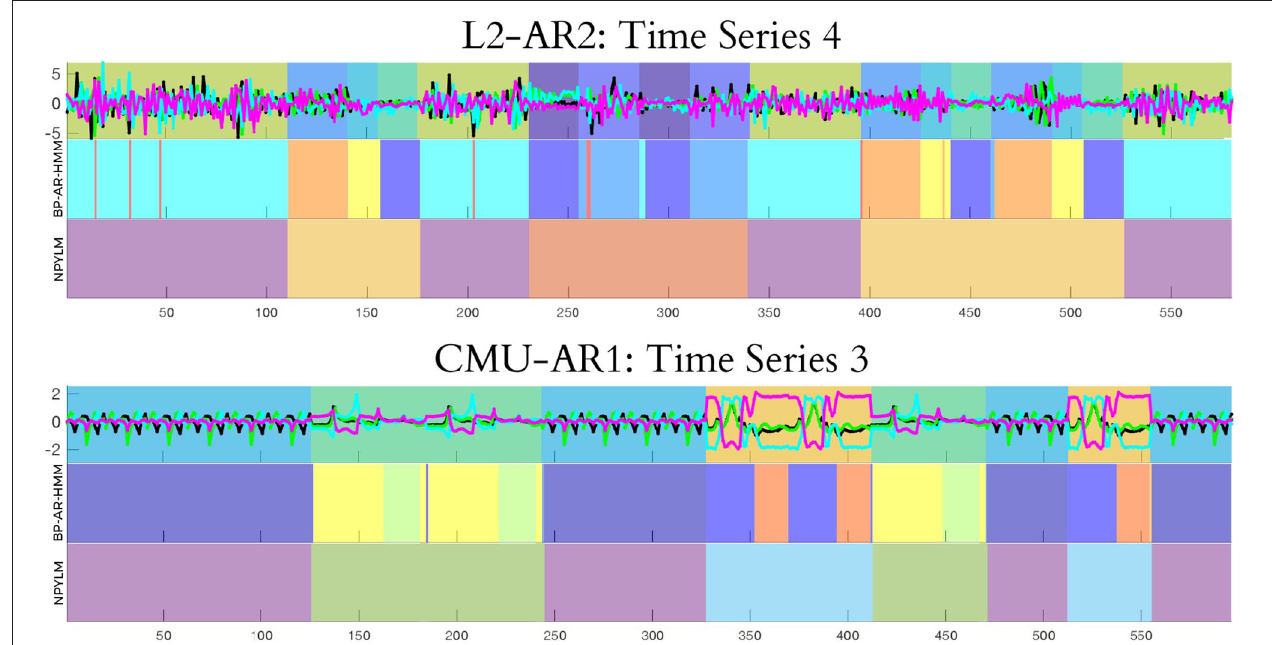
FIGURE 3 | Plot of the first four dimensions of the input data and an example of segmentation results for both EB and UB steps. (Top) Toy data. (Bottom) CMU motion data.